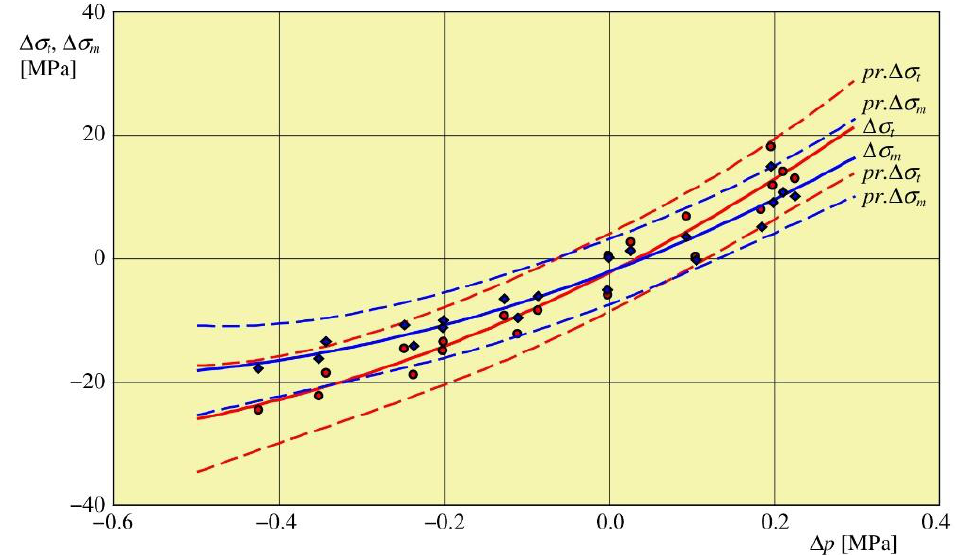
Figure 13. Applied polynomial regression models of the second degree for the dependencies ∆ σ t = f ( ∆ p ) and ∆ σ m = f ( ∆ p ) and marking of their 95% prediction interval.